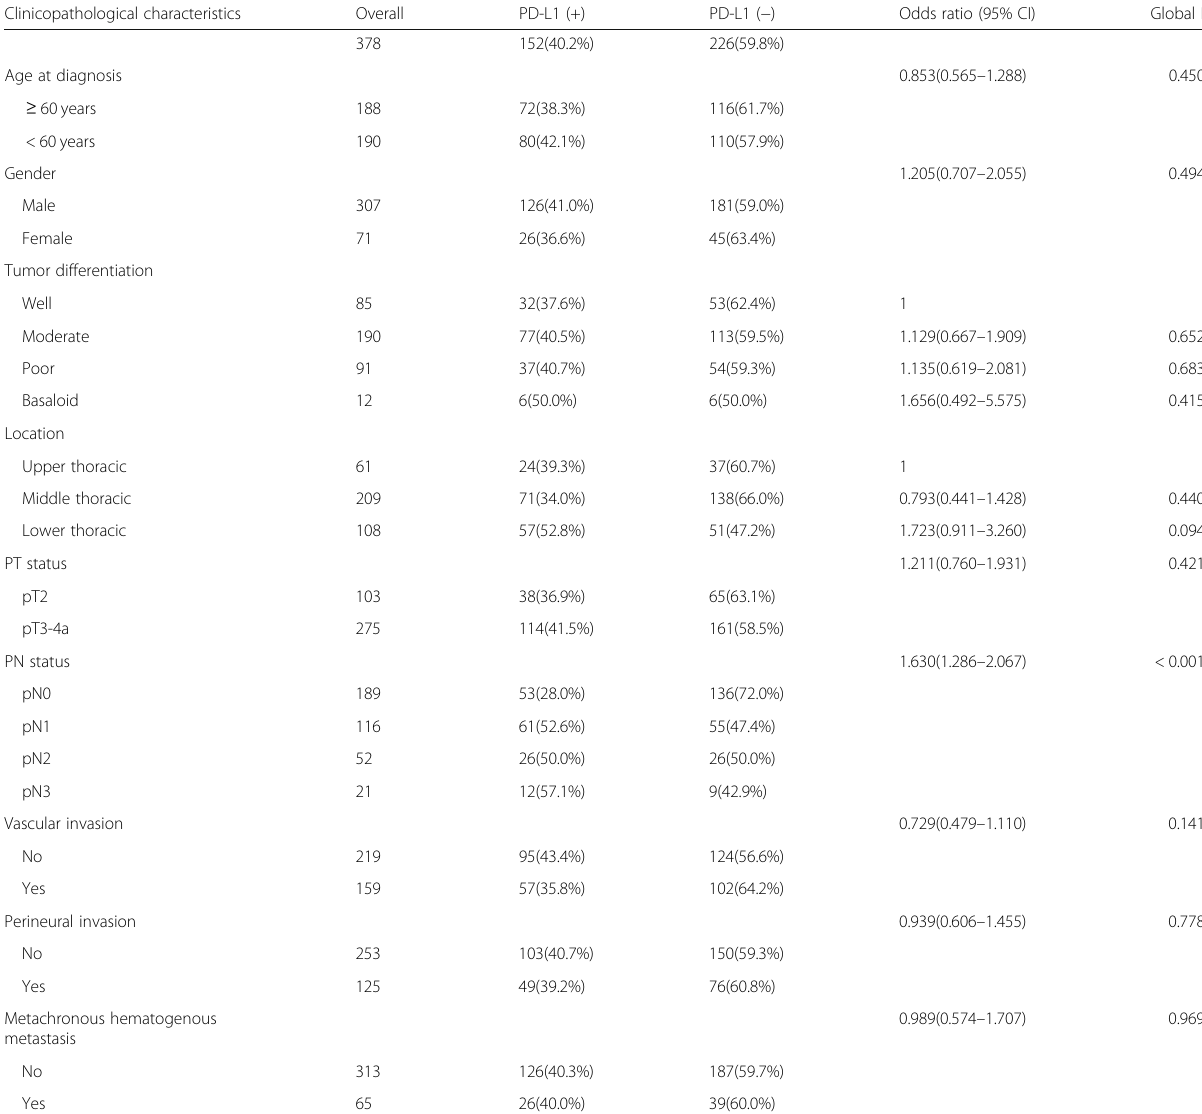
Table 3 Relationships between clinicopathological characteristics and PD-L1 expression in tumor-infiltrating immune cells Clinicopathological characteristics